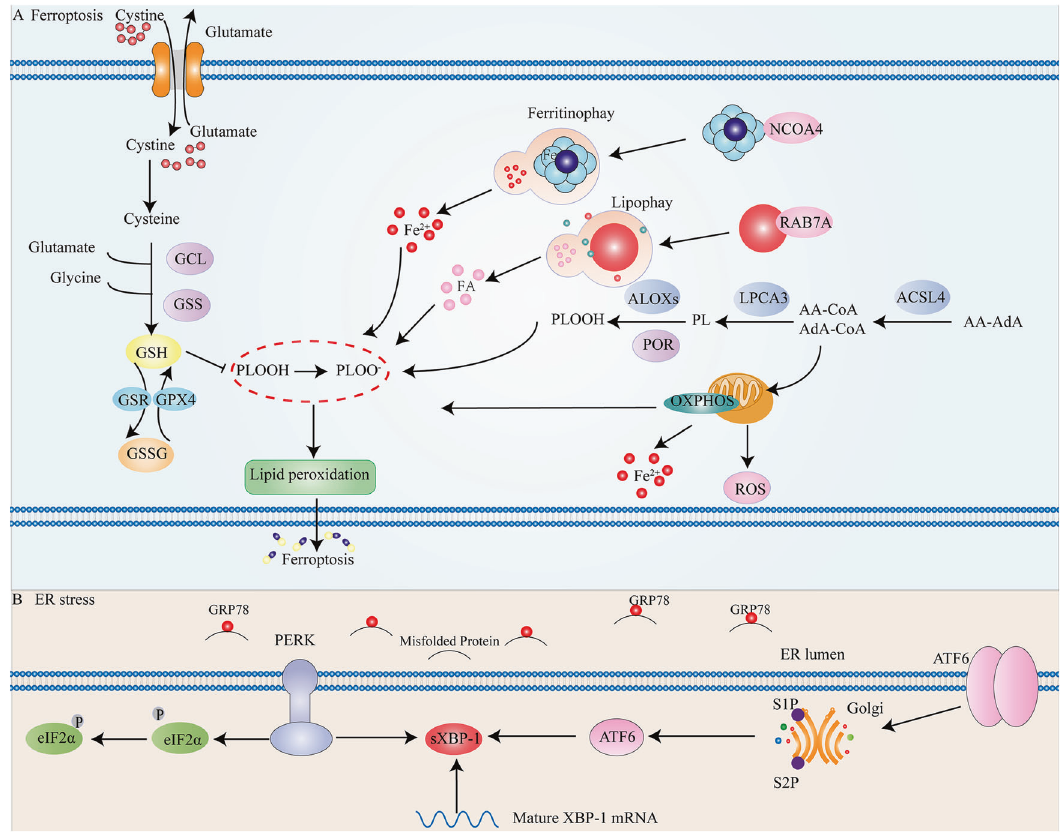
Fig. 3 The mechanism of ferroptosis and endoplasmic reticulum stress. A Release process of ferroptosis cells. B Activation of sXBP-1 in ER